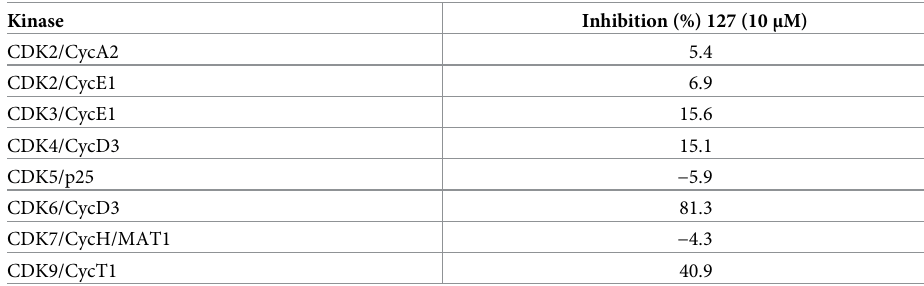
Table 1. Inhibitory effects of compound 127 on various